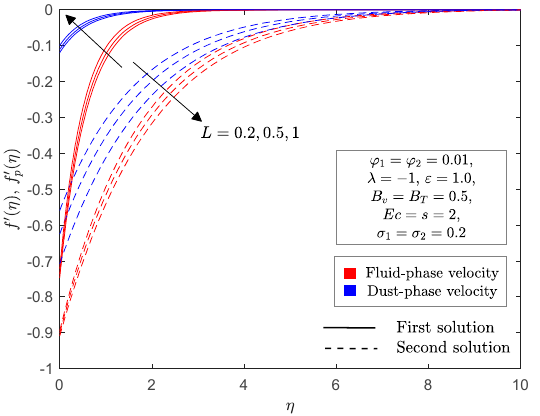
( ) ( ) , f f η η′′ for selected values of L Figure 15. p ( ) ( ) Figure 15. f (cid:48) ( η ) , f p (cid:48) ( η ) for selected values of L . , f f η η′′ for selected values of L Figure 15. p